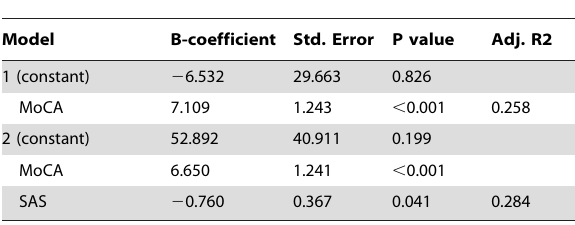
Table 7. Multiple linear regression analysis of age, gender, education, post-RT interval, chemotherapy, SAS, SDS and MoCA to predict QOL.